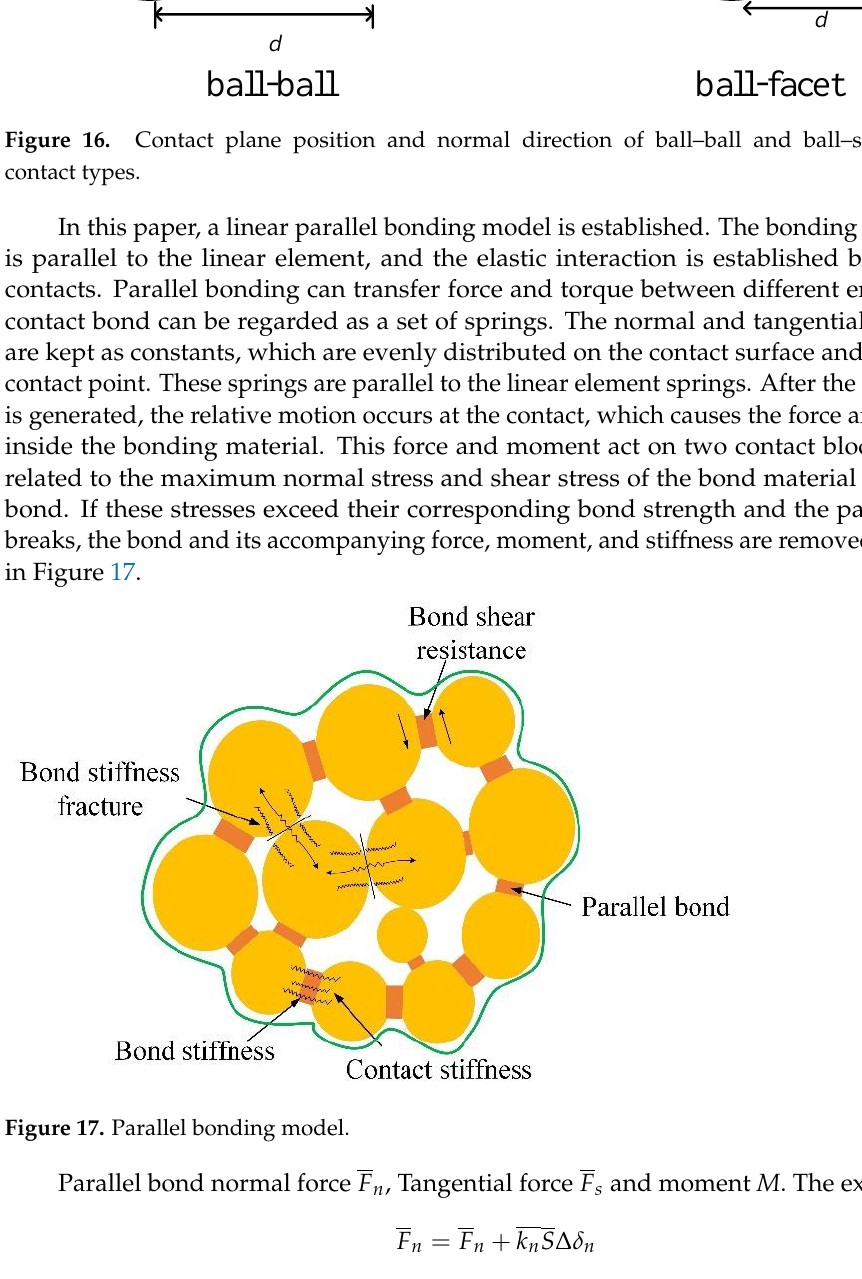
Figure 16. Contact plane position and normal direction of ball–ball and ball–surface basic contact types.